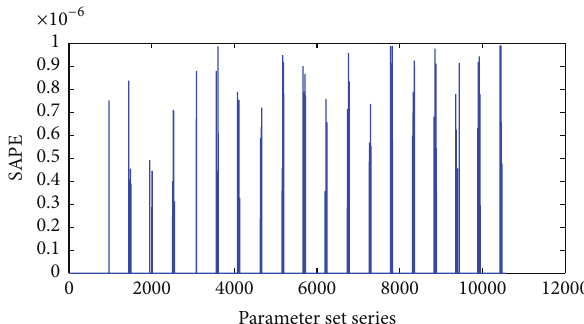
Figure 2: Results of Lorenz time series’ multistep prediction: the SAPE of parameter